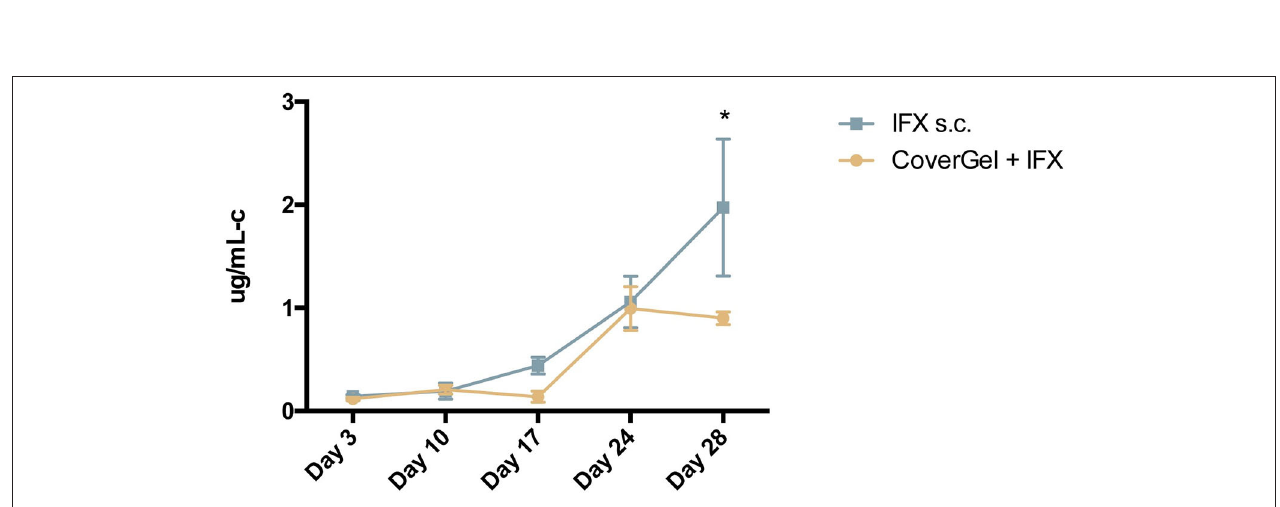
FIGURE 9 | Evolution of antibodies to Infliximab (ATIs) in serum for: CoverGel + IFX group and IFX s.c. group. Graph represents the concentration of ATIs ( µ g/mL-c calibrated in comparison to a polyclonal rabbit α -IgG standard). * p < 0.05.